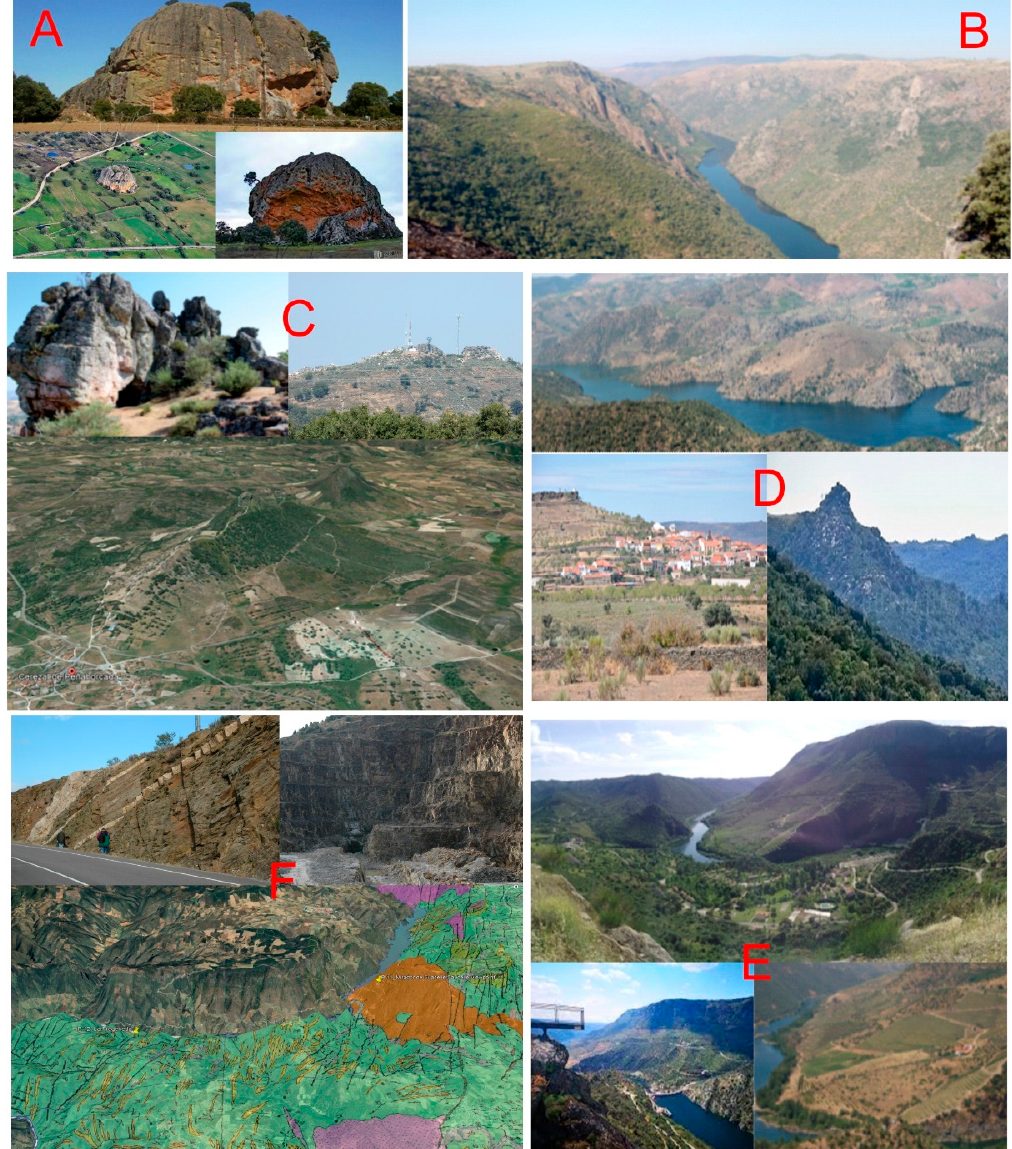
Figure 11. ( A ) Image of the rock seen from the front (top), which stands out on the current surface (bottom left) and with important structures of wind erosion (bottom, right). ( B ) View of the riverbed of the Duero river from the La Code viewpoint. ( C ) Panoramic view of the Sierro de Cerezal de Peñahorcada and detail of the quartz dike at its highest point where it is resistant to erosion (top right and left). ( D ) Capture of a panorama from the Bajo Duero de Vilvestre (above). In the lower part, one can see the town of Vilvestre with the elevated sector of El Castillo (left) and the pyramidal morphologies near the viewpoint in the riverbed (right). ( E ) Panoramic of the folded Ordovician materials on the Portuguese slope (top) and view of the softer slope (bottom left) and lower part of the slope with crops and terraces (bottom right). ( F ) Location of the La Fregeneda stop on the geological cartography wherein there are visible abundant pegmatite dikes (yellow), detail of the dikes in a section of the road (top left), and a view of the cut from Mina Feli (top right) where hydrothermal seams with cassiterite are cut by discordant pegmatites. Feli Mine view (top right) and hydrothermal quartz seams in reel cuttings (top left). One can also appreciate the previous stop of the Mirador de Saucelle and the Ordovician reliefs in the Portuguese part or right bank of the Douro